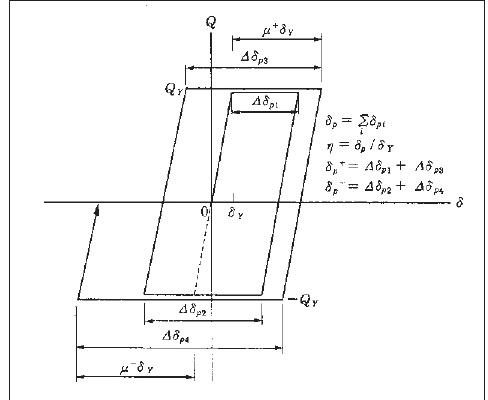
Fig. 4. Elastic-perfectly plastic type of Q −δ relationship.